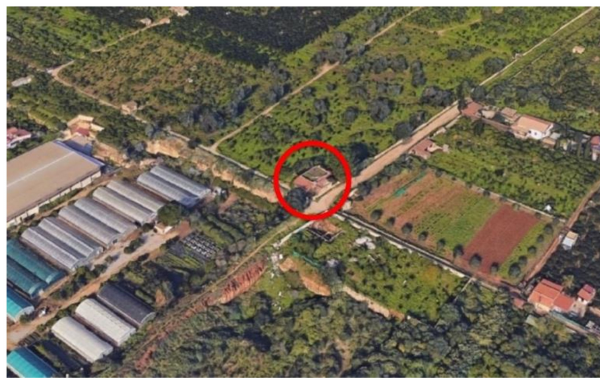
Figure 1. Site of the installation of the experimental field (source: Google-Earth).